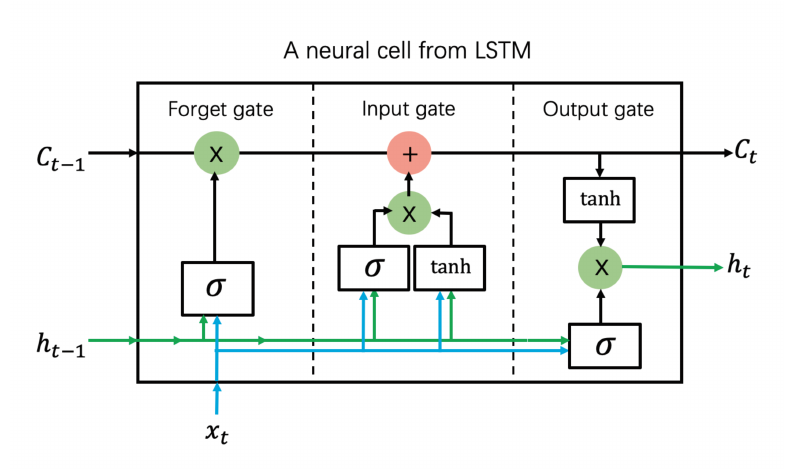
Figure 7. Simplified neural cell of LSTM, showing its three gates. C t , x t , and h t represent the cell state, input, and output in time step t ,